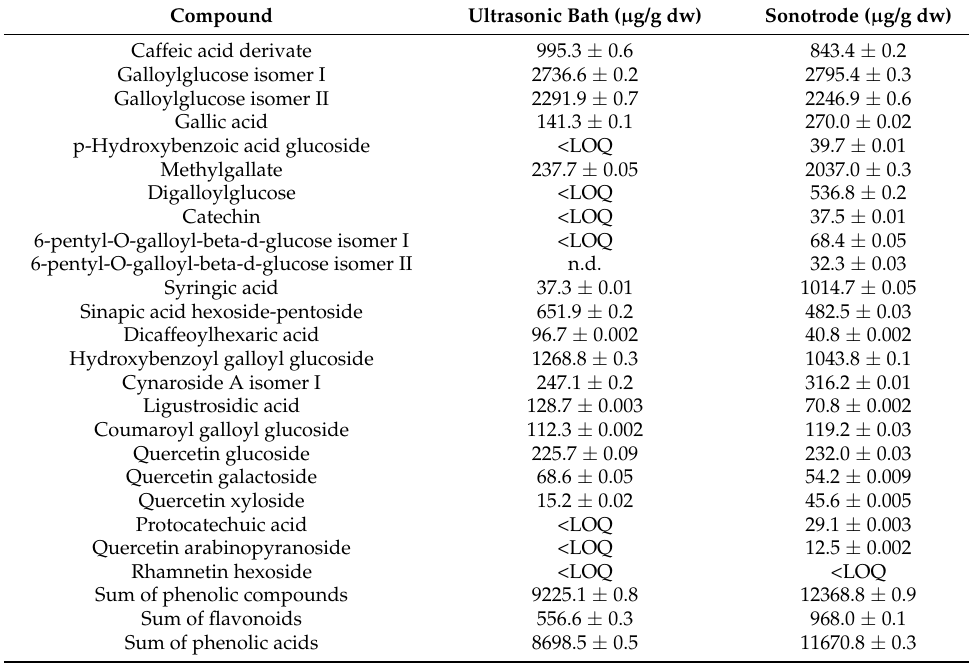
Table 6. Quantification of phenolic compounds in sonotrode and ultrasonic bath of mango peel byproducts by HPLC–MS expressed as µ g/g